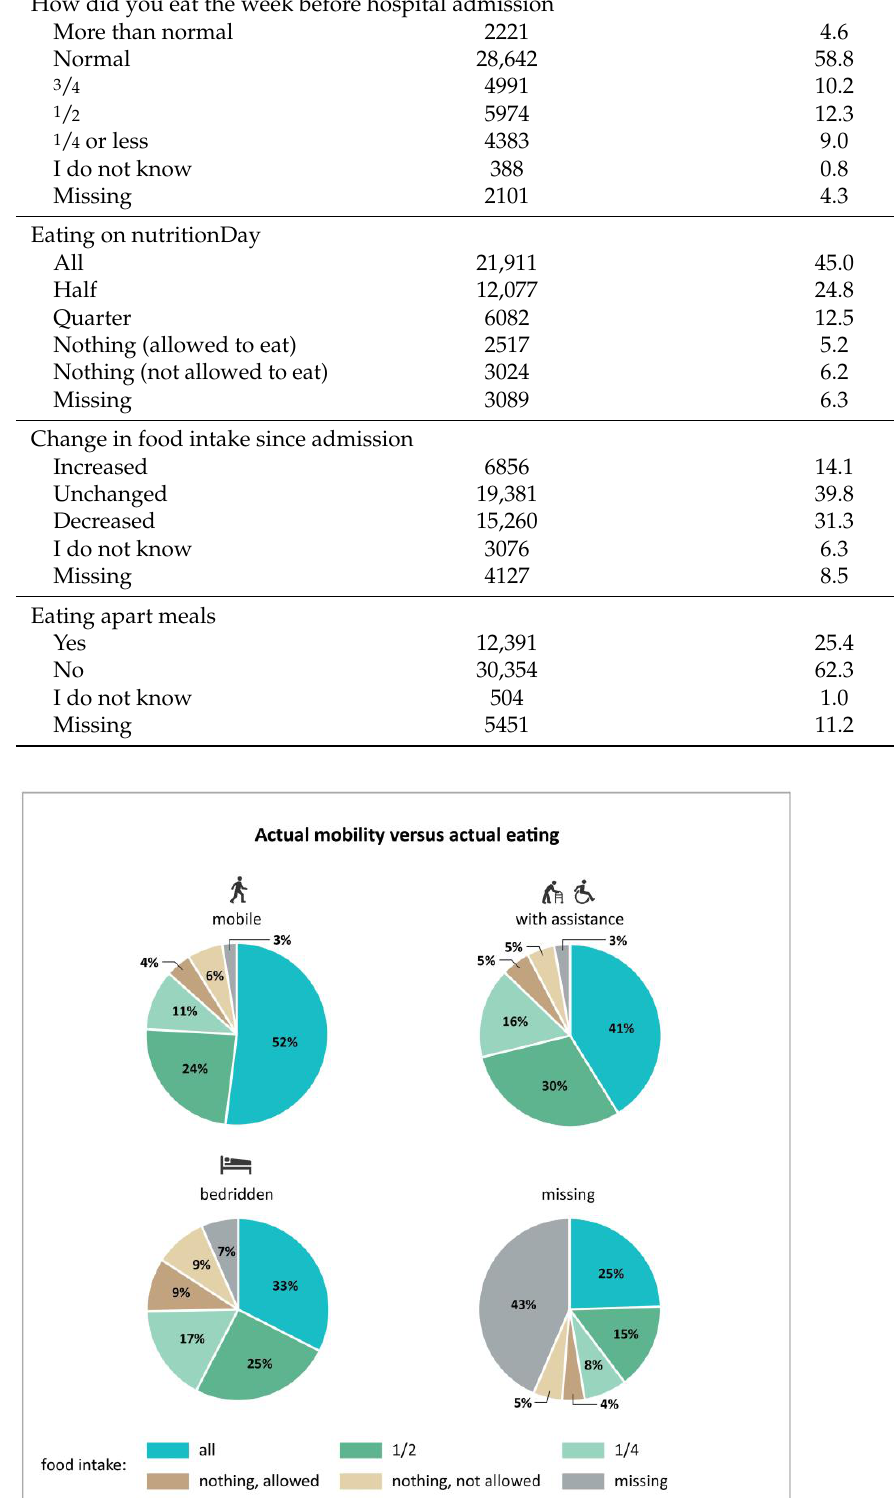
Figure 4. Change of food intake versus change in strength between admission and nutritionDay ( n = 38,811), categories “I don’t know” and “missing” are excluded from the graph.